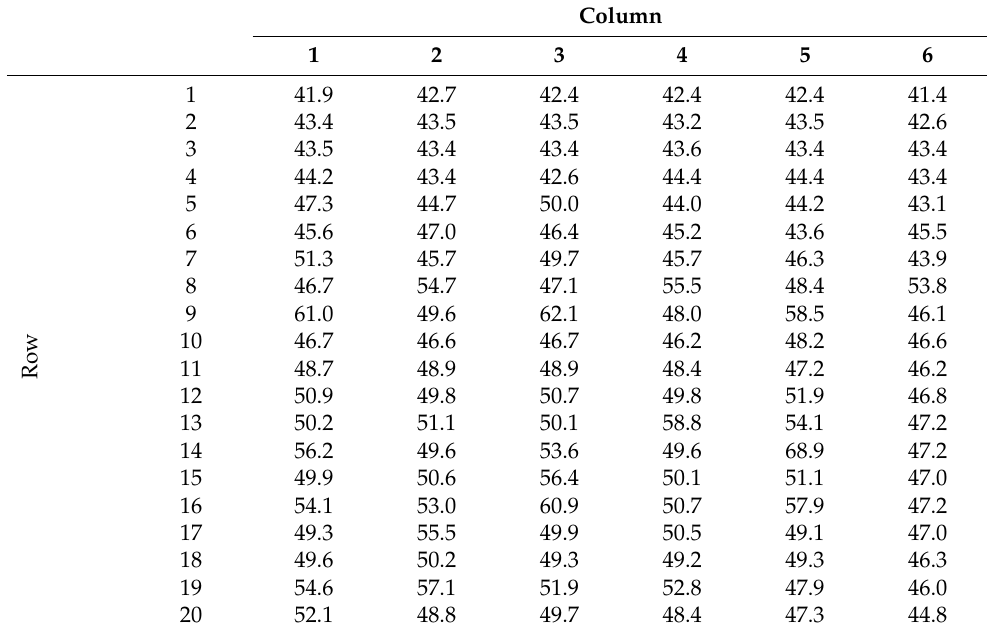
Table 5. Distribution of the apparent temperature value of the new (reference) PV module.